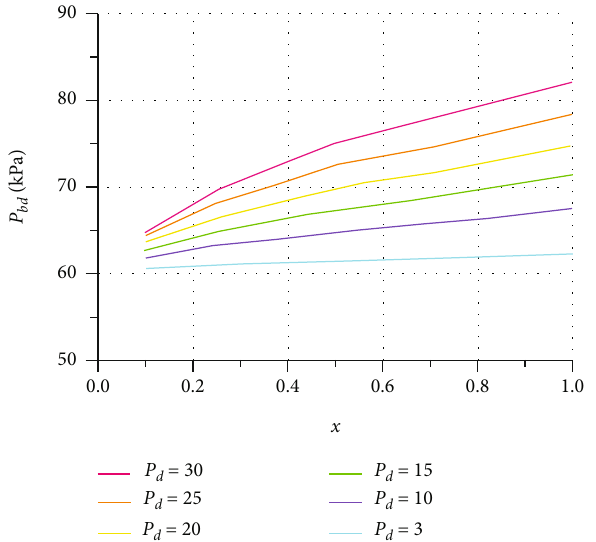
Figure 15: Relation between mass fl ow rate M bd and pressure P a at di ff erent di ff erential pressure P d .